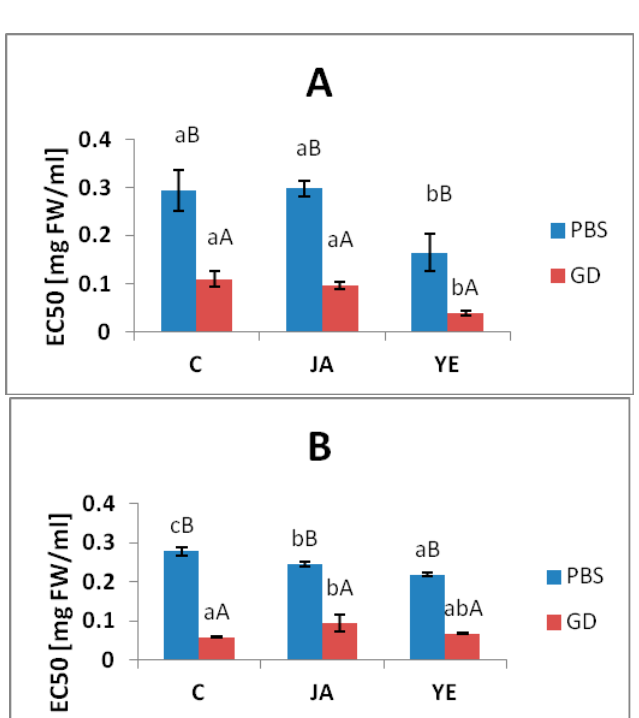
Figure 1. Lipoxygenase ( A ) and cyclooxygenase-2 ( B ) inhibitory activity in the control, elicited lovage bu ff er (PBS) extracts, and gastrointestinally digested (GD) extracts. C—extracts from the control